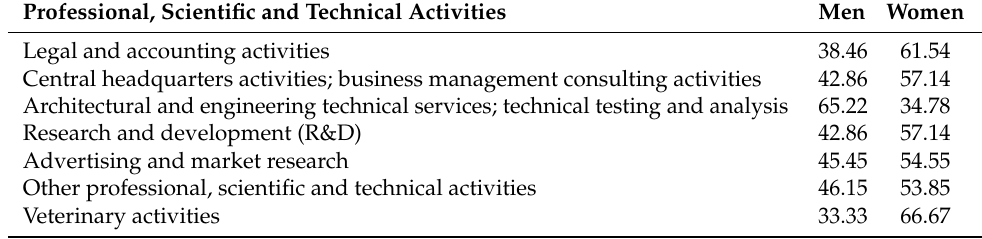
Table 4. Percentage distribution of employment by sectors in the activity branch Professional, scientific and technical activities.